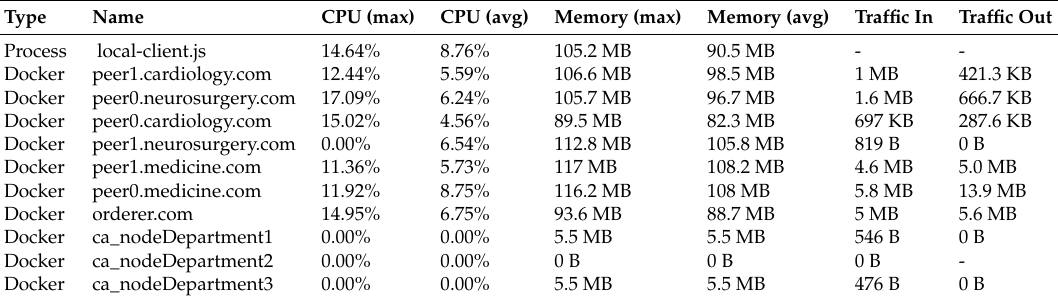
Table 6. Resource utilization analysis of the proposed